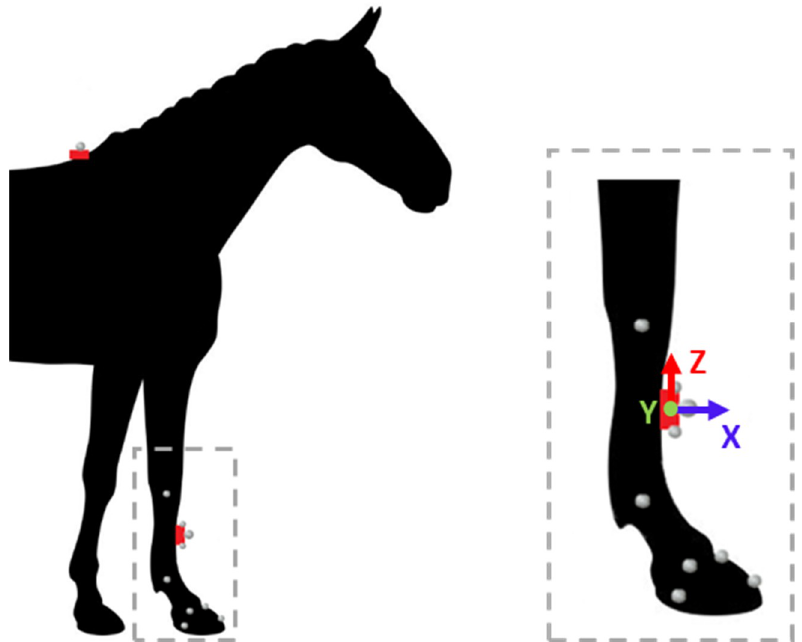
Figure 1. Placement of the two IMUs (represented in red) and the kinematics markers according to points of interest: six at anatomical points: carpal joint, metacarpo‐phalangeal joint, hoof (toe, heel, front coronary band, lateral coronary band), one at the center of wither’s IMU and three on canon bone’s IMU (center, up lateral part, down lateral part). One additional free marker was used for synchronization keystroke on the wither’s marker.